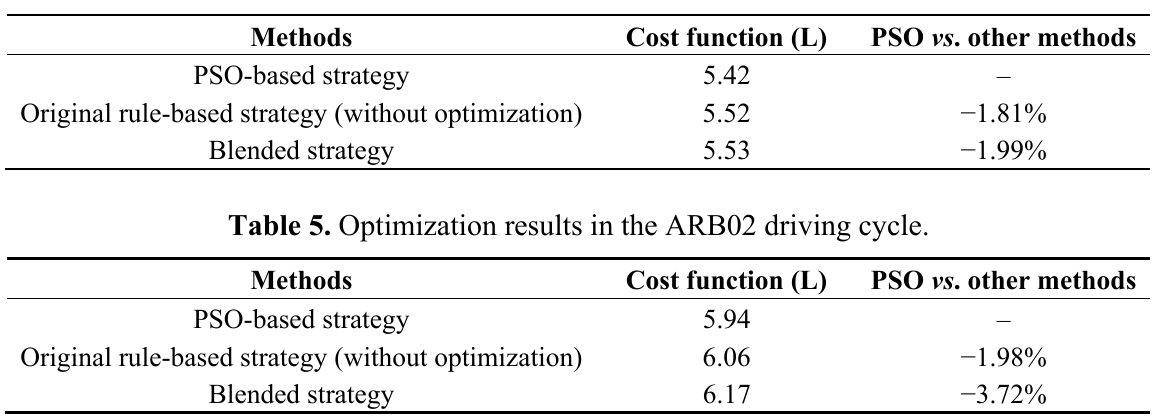
Table 4. Optimization results in the REP05 driving cycle.